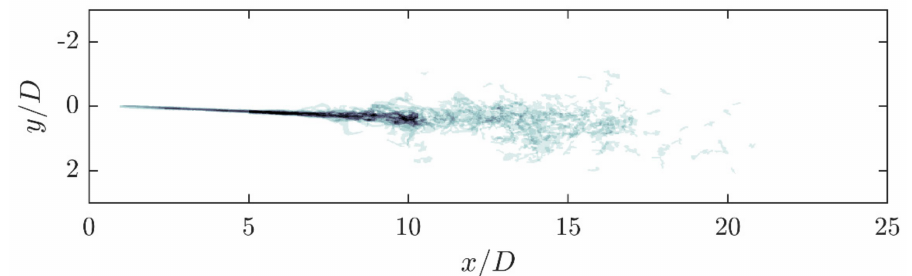
Figure 20. Superposition in the wake area of the orifice in the test facility scaled to scale 5 of the droplets injected on the axis of symmetry (r ∗ = 0) in front of the orifice at Re = 5700.